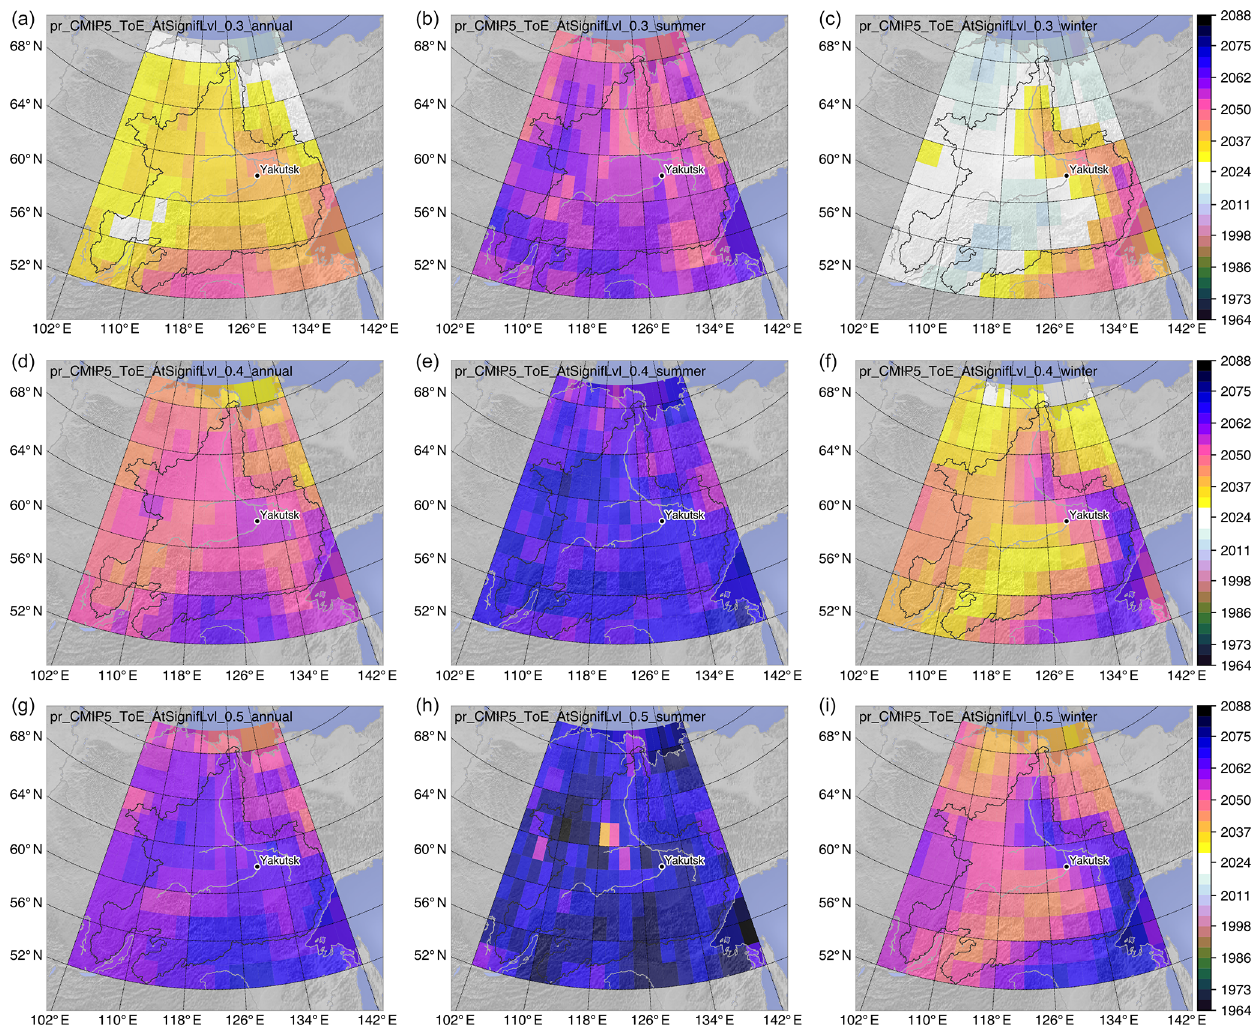
Figure 9. Time of emergence for precipitation (pr) according to 30% (a–c) , 40% (d–f) , and 50% (g–i) emergence for annual (a, d, g) , summer (b, e, h) , and winter (c, f, i) values. Values are the mean over all individually determined ToE values for each of the 65 climate simulations. Artefacts at 50% emergence in summer (earlier ToE than for 40%) are due to the limited number of model simulations with